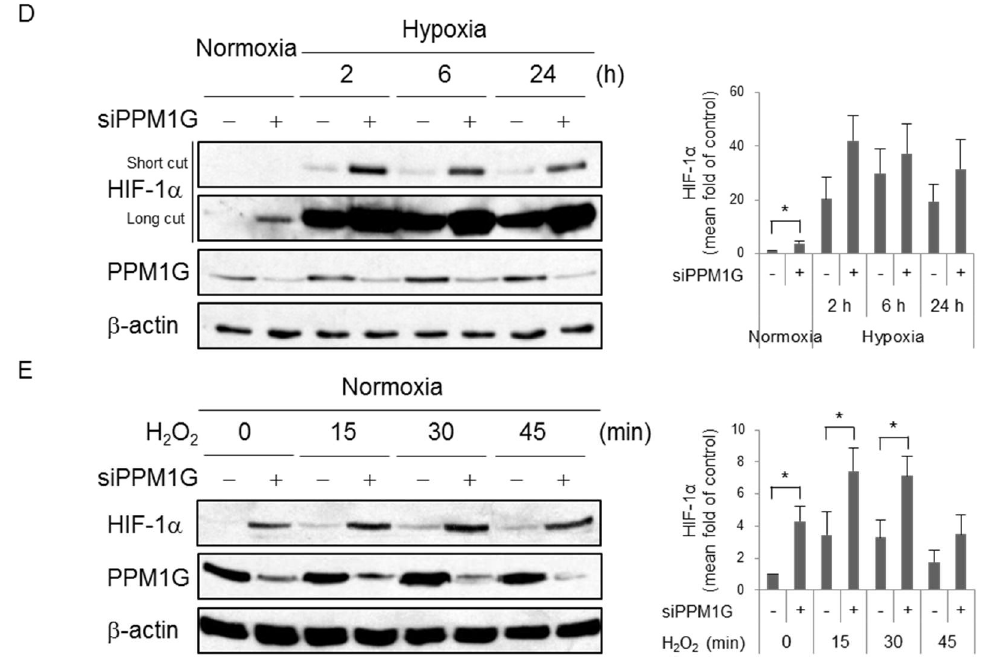
Figure 2. PPM1G affects HIF-1 α expression under hypoxic and oxidative stress conditions. ( A – E ) HEK293T cells were co-transfected with FLAG-HIF-1 α , MycHis-Empty ( − ), MycHis-PPM1G (+), control siRNA ( − ) or PPM1G-targeting siRNA (siPPM1G). The HEK293T cells were exposed to normoxia or hypoxia ( A – D ), or 0.5 mM H 2 O 2 ( E ) for the indicated durations. Expression of ectopic FLAG-HIF-1 α ( A , B ) or endogenous HIF-1 α ( C – E ) was determined by Western blotting. * p < 0.05; significantly different from the matched control group.